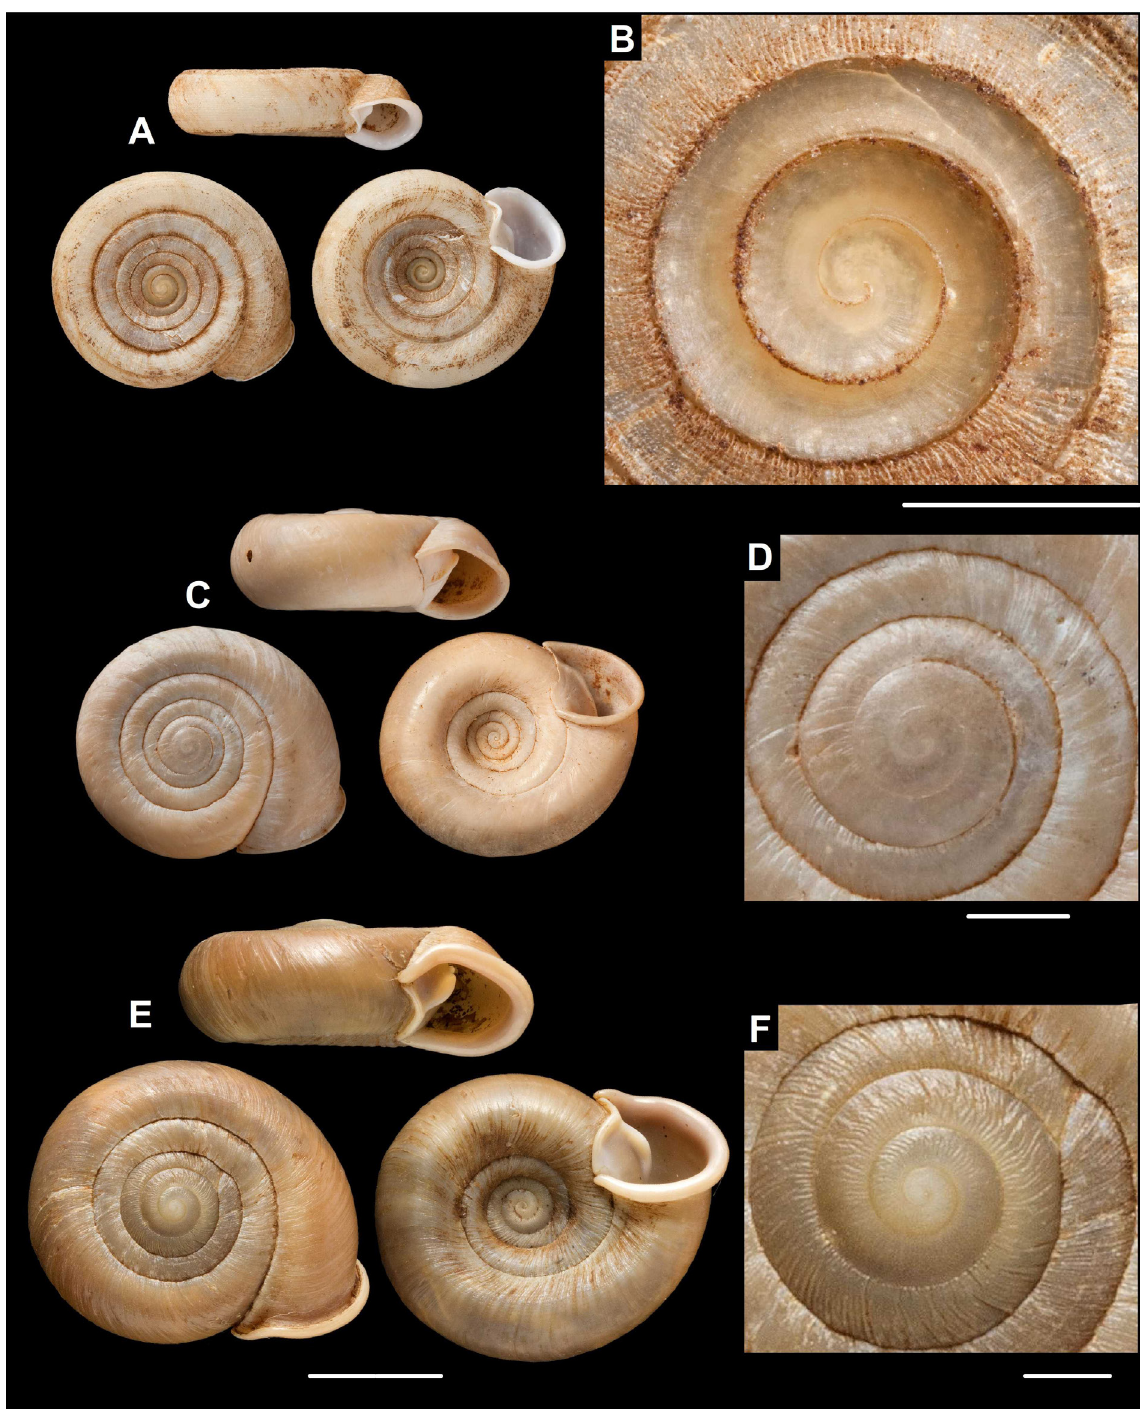
Fig. 6. Shells and protoconchs of Chersaecia Gude, 1899. A–B . C. austeni (Gude, 1899), lectotype (NHMUK 1903.06.01.1014.1). C–D . C. brachyplecta (Benson, 1863) comb. nov., syntype (NHMUK 1954.6.2.282). E–F . C. smithiana (Gude, 1897) comb. nov., syntype (NHMUK 1888.12.4.1555). Scale bars: A, C, E = 10 mm; B, D, F = 2 mm. All photos: H.